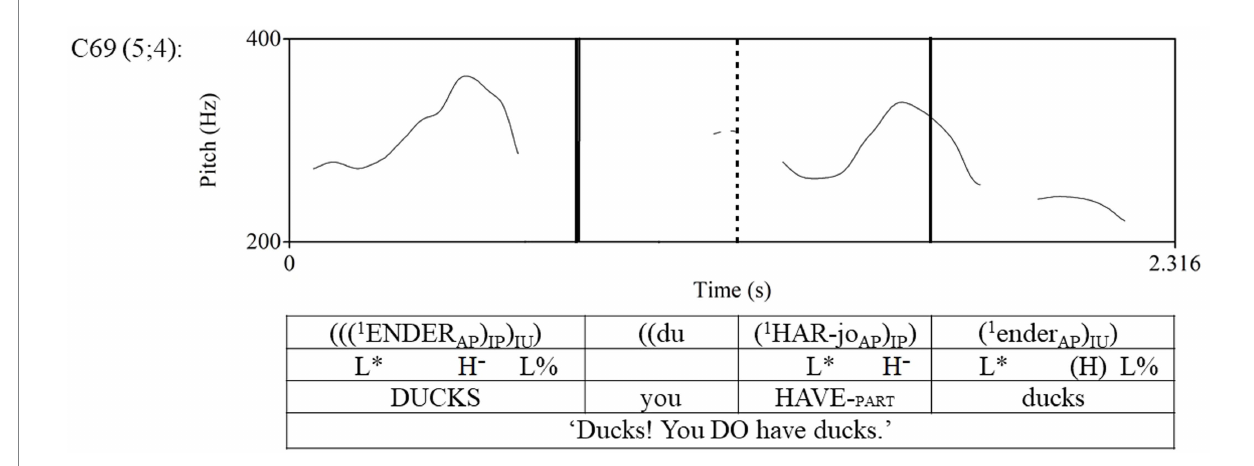
FIGURE 6 PF production by 5-year-old in the Inf-Bel condition.